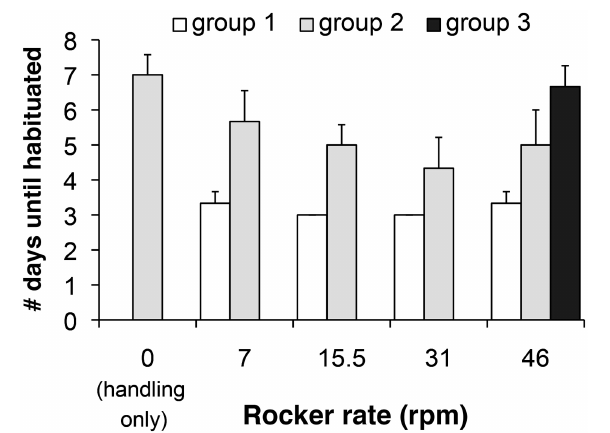
FIGURE 2 | Hibernating AGS were subjected to handling (being transferred to a new cage) and/or movement as described and the total number of days at the particular stimuli is shown on the y-axis. AGS that had a change in RR of less than 1 over three consecutive days were considered habituated and the total number of days, including these 3 days, is shown. Rocker rate is shown as rotations per minute (rpm). n = 3 AGS groups 1 and 2; n = 7 AGS group 3, data are presented as mean ± s.e.m. The statistical analysis is described in the text.